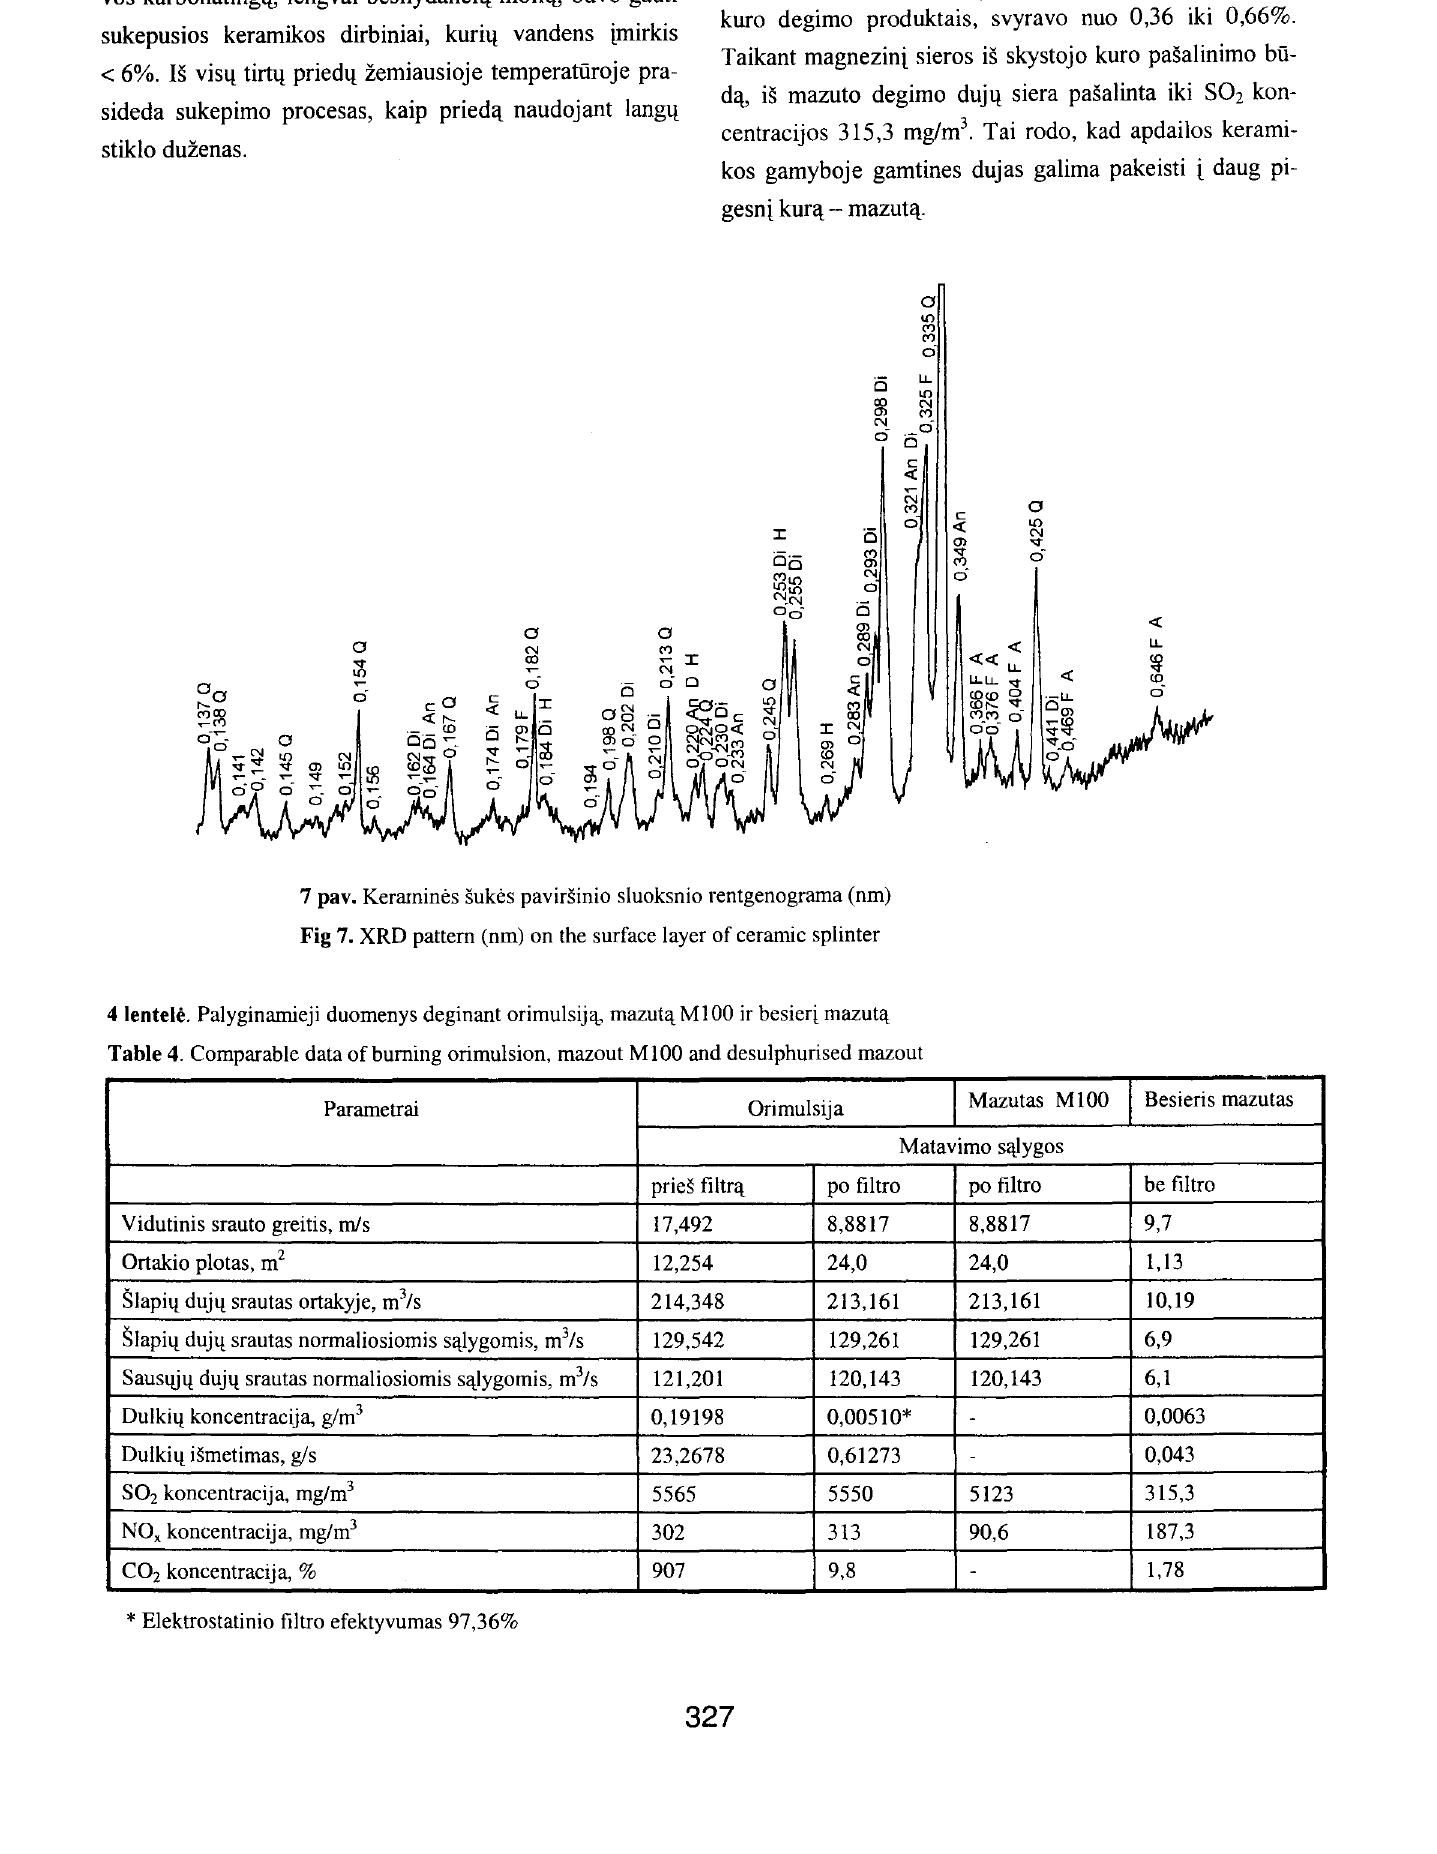
Table 4. Comparable data of burning orimulsion. mazout MIOO and desulphurised mazout